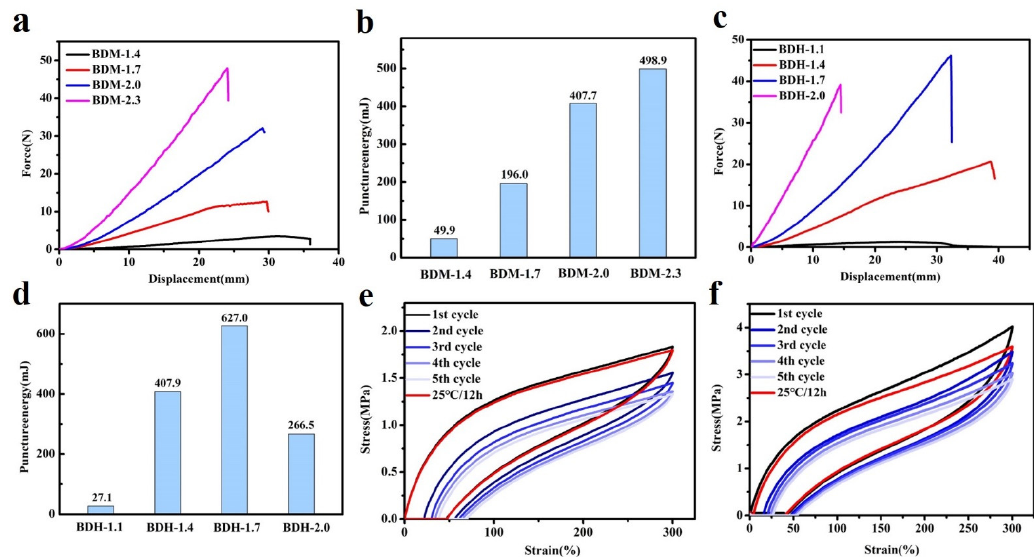
Figure 3. ( a ) Force-displacement curves for BDM-based elastomer; ( b ) Puncture energies of BDM- based elastomers calculated from force-displacement curves; ( c ) Force-displacement curves for BDH-based elastomer; ( d ) Puncture energies of BDH-based elastomers calculated from force-displacement curves; ( e , f ) Cyclic test curves of BDM-1.7, BDH-1.7 elastomer.